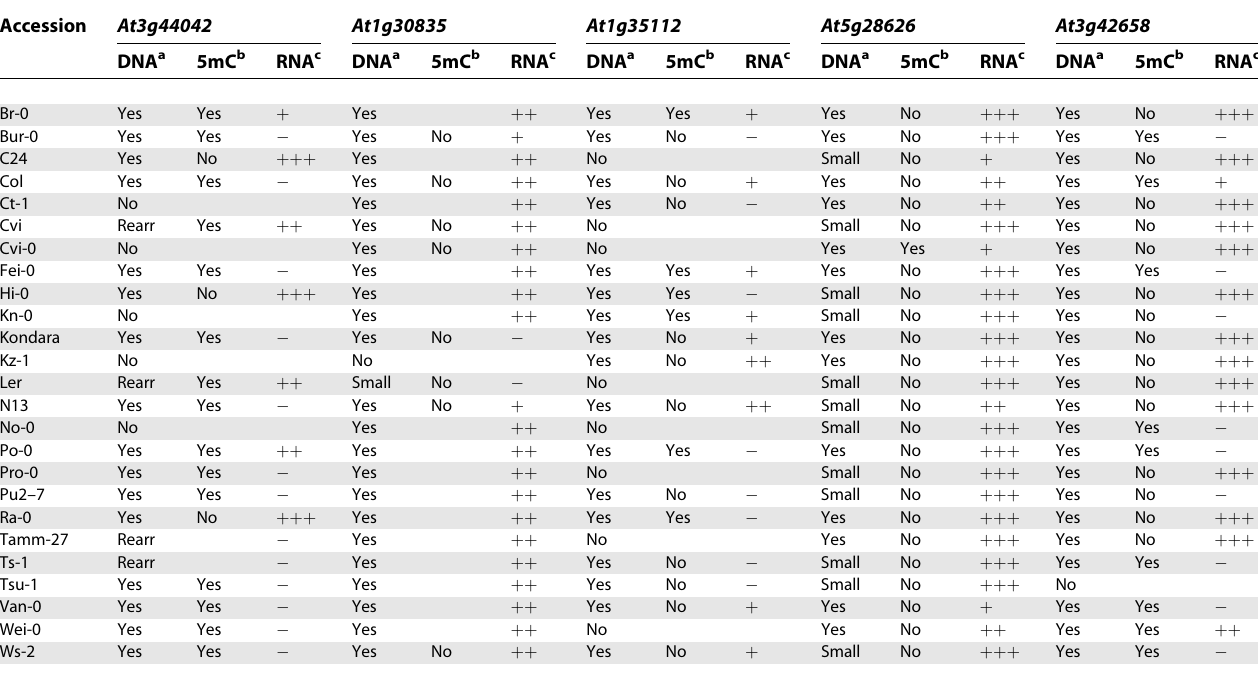
Small a Genomic DNA amplification using gene-specific primers (see Table S2); Rearr (Rearranged), refers to cases where we could amplify a full-length copy of the element from that accession using primers located inside the element, but could not amplify the full-length element using primers located in the flanking region. We believe the full-length element is present in these accessions, but located in a different genomic context than in the Col genome. Small, a lower molecular weight PCR product was generated compared to Col. b Cytosine methylation was determined by a McrBC PCR assay using gene-specific primers. Blank spaces indicate that the sample was not tested. c Steady-state transcript levels were assayed by RT-PCR. (cid:1) , none detected; þ , low; þþ , moderate; þþþ ; high. Blank spaces indicate that the sample was not tested. DOI: